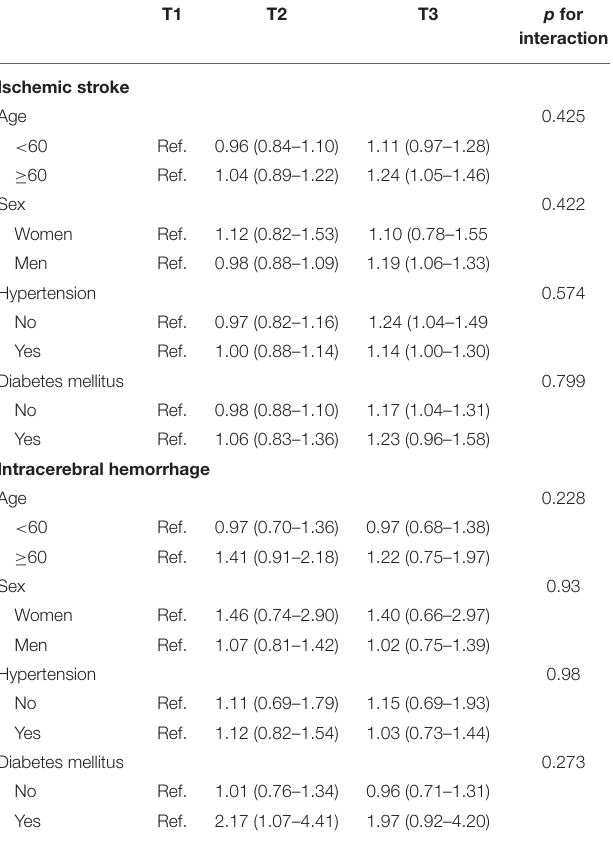
TABLE 3 | Multivariate-adjusted hazard ratios (HR) † for stroke subtypes according to the tertile of 2-year TC change, stratified by sex and selected risk